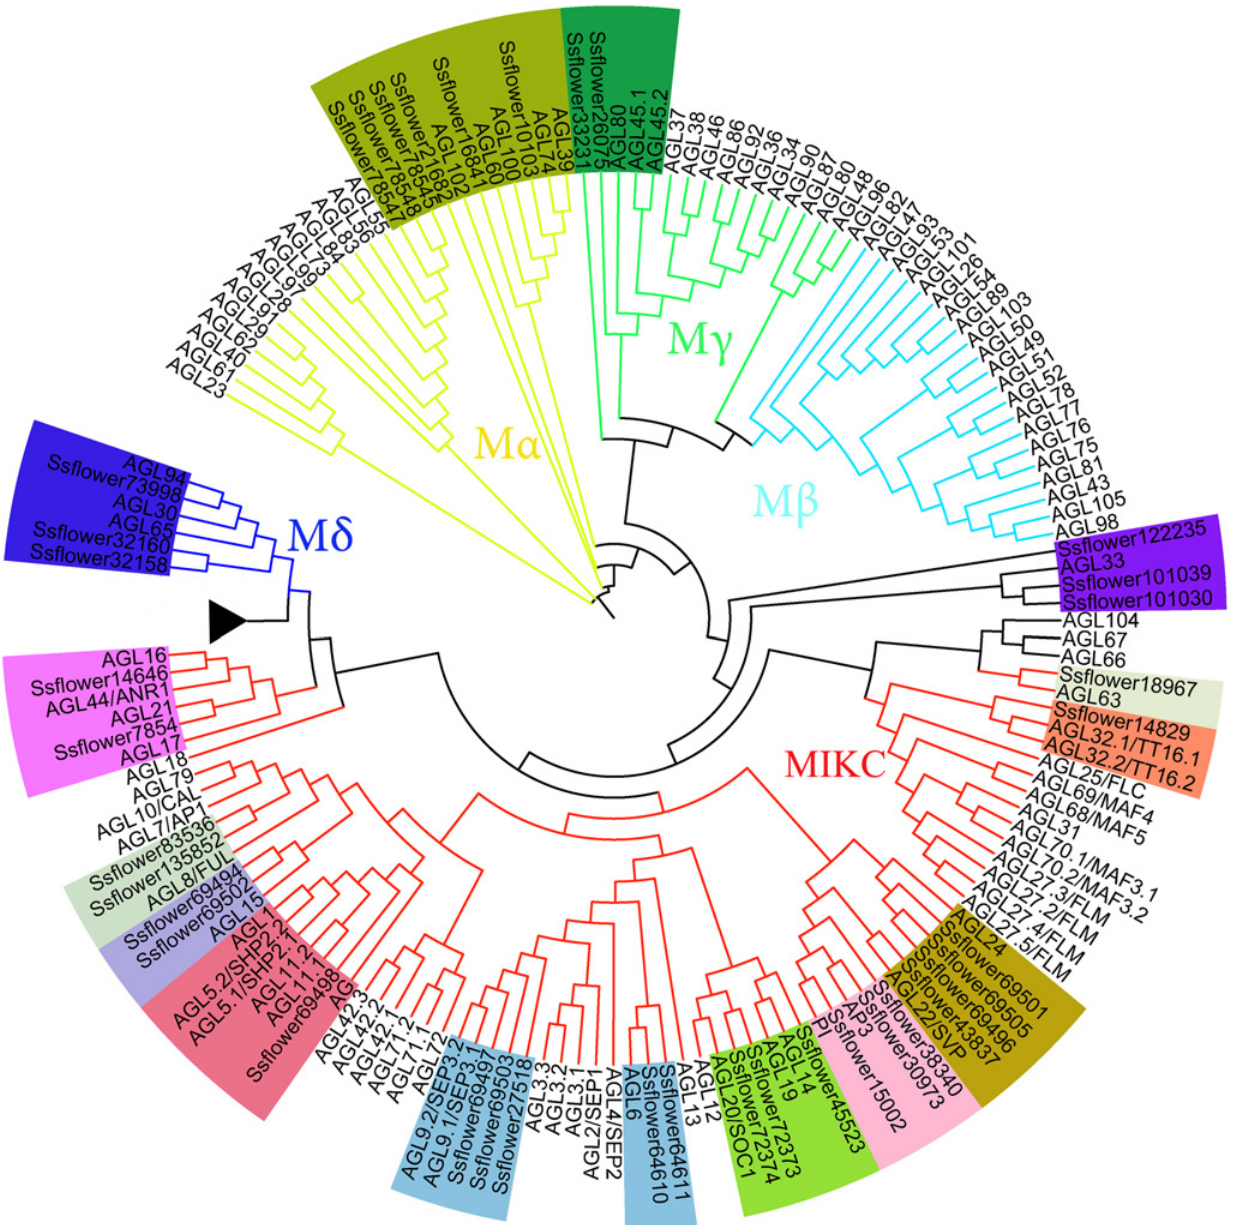
Fig 5. Phylogenetic Analysis of MADS-Box Containing Proteins of S. sebiferum . Red branches, MIKC; Blue branches, M δ ; Cyan branches, M β ; Green, M γ ; gold, M α